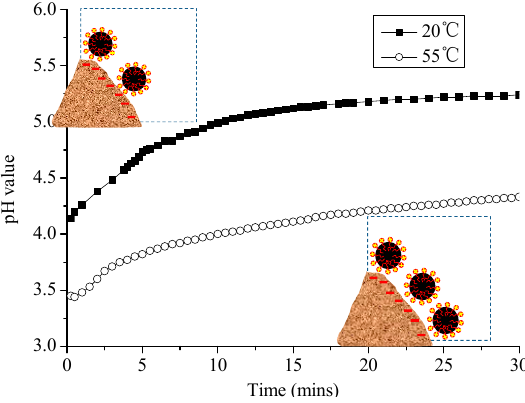
Figure 8. pH value of emulsified asphalts–sand system changes with time at different temperatures.